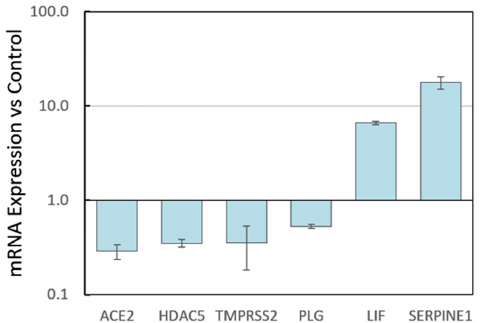
Figure 2. Regulation of pro- and antiviral genes by PB125. HepG2 cells were cultured overnight in 24-well plates with control vs. 16 µ g / mL PB125 and gene expressions were determined using RNA-seq analysis on four biological replicates. All six genes di ff ered from control by p <